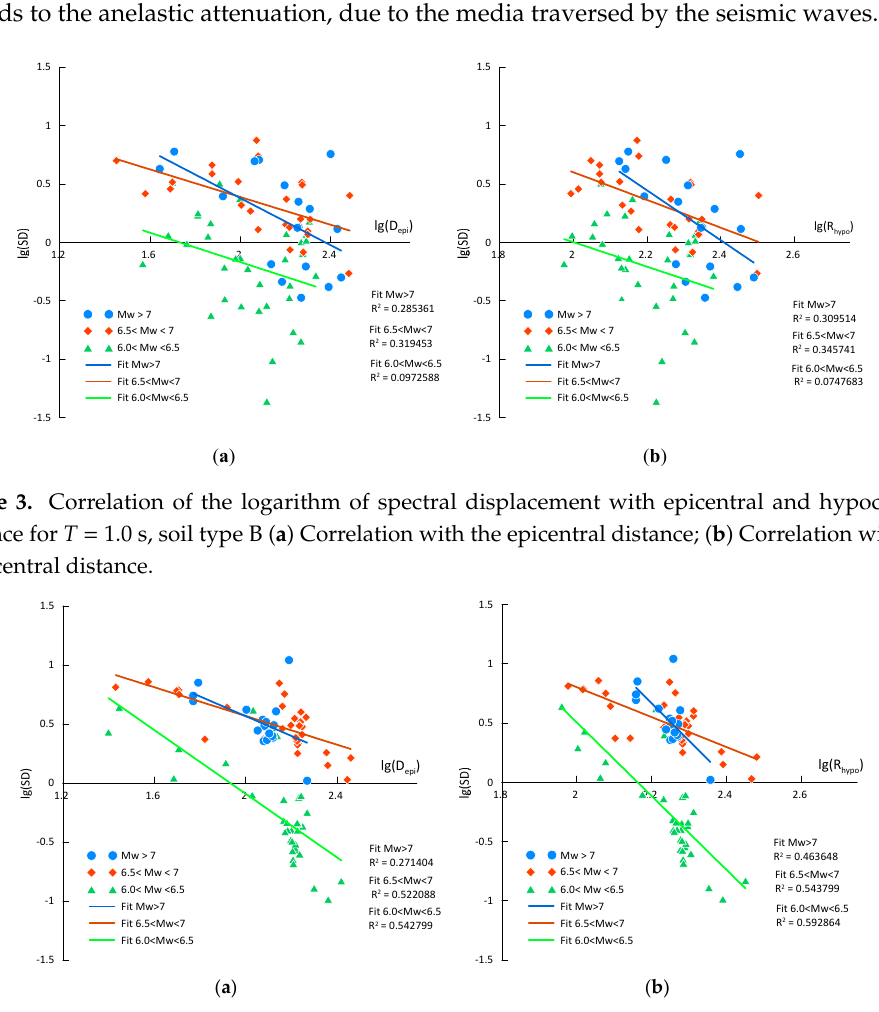
Figure 4. Correlation of the logarithm of spectral displacement with epicentral and hypocentral distance for T = 1.0 s, soil type C ( a ) Correlation with the epicentral distance; ( b ) Correlation with the hypocentral distance.